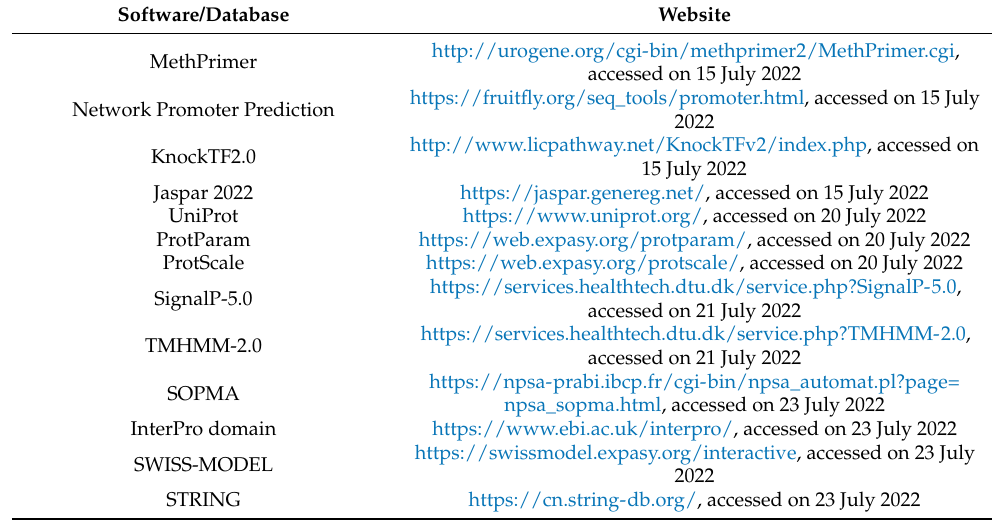
Table 1. Bioinformatics analysis